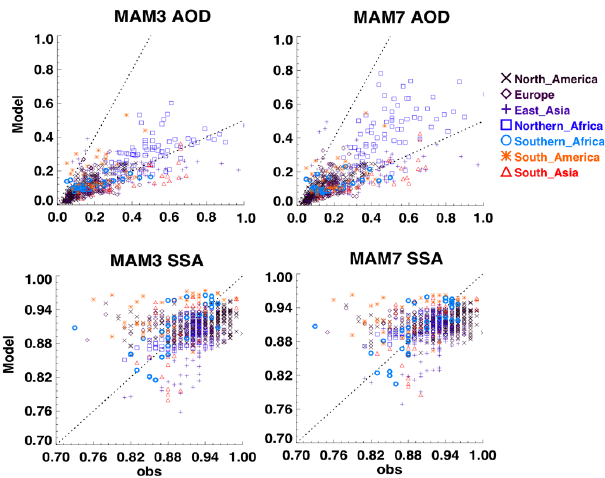
Fig. 24. Comparison of modeled monthly aerosol optical depth (AOD) (upper) and single scattering albedo (SSA) (lower) at 550nm from MAM3 (left) and MAM7 (right) with observations from the AERONET (http://aeronet.gsfc.nasa.gov) at 75 sites in seven regions (North and South America, Europe, East and South Asia, and Northern and Southern Africa) over the globe. Dashed lines are 1:2 or 2:1 for AOD (upper) and 1:1 for SSA (lower).